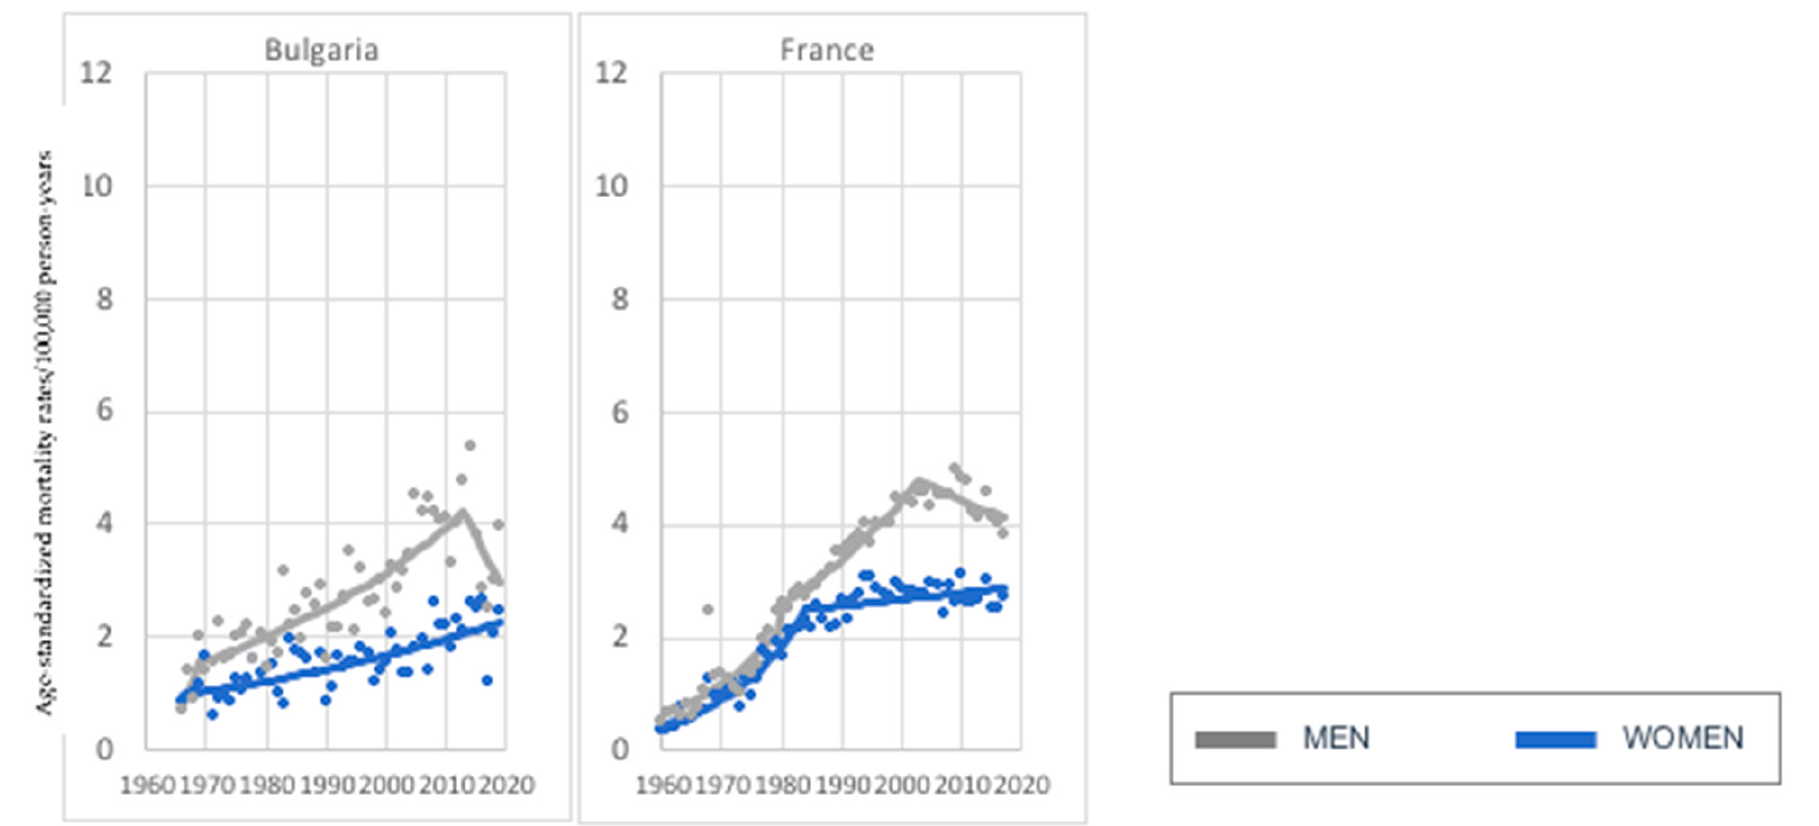
Figure 3. Melanoma mortality trends—2 countries with an investigated increase in women and decrease in men, age group 45–74 years old.